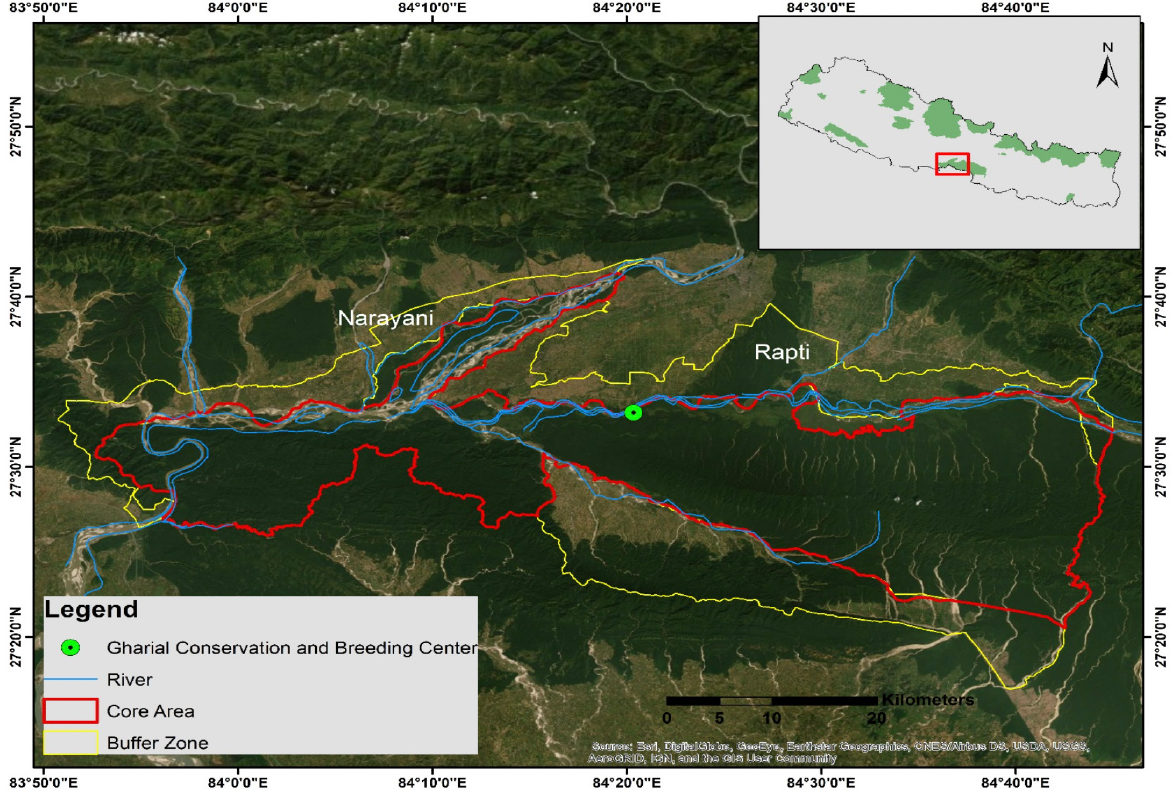
Figure 1. Map of Chitwan National Park showing location of the Gharial Conservation and Breeding Center.